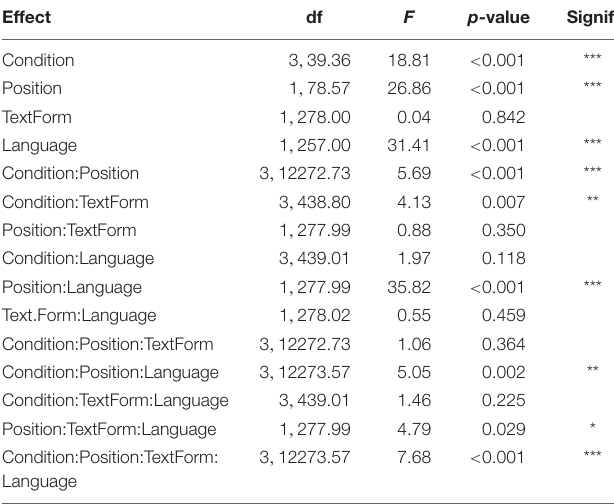
TABLE 9 | Mixed model ANOVA table for all 4 experiments.